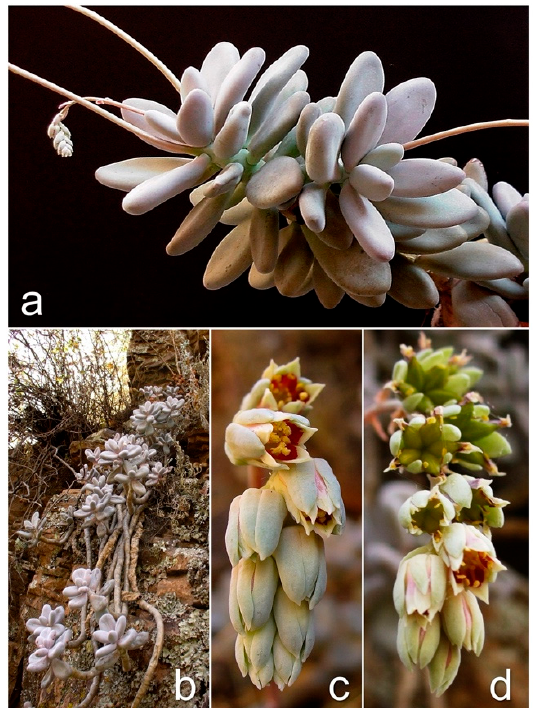
Figure 2. Pachyphytum caesium Kimnach & Moran. ( a ) Leaves obovate-oblong with subobtuse apex, grayish to grayish-purple, 3–7 cm, forming lax terminal rosettes; axillary inflorescences of long-stalked cincinnus, simple, 6–20 flowers. ( b ) Rupicolous plant, stems commonly branched basally, erect in young plants but elongated and pendulous with age, reaching 30–40 cm. ( c ) Flowers short pedicellate, tubulars, perianth almost equal in length, corolla cream to cream-green with a reddish spot centrally; nectaries yellowish [26,27]. ( d ) Fruits of polyfollicles with many oblong brownish seeds.